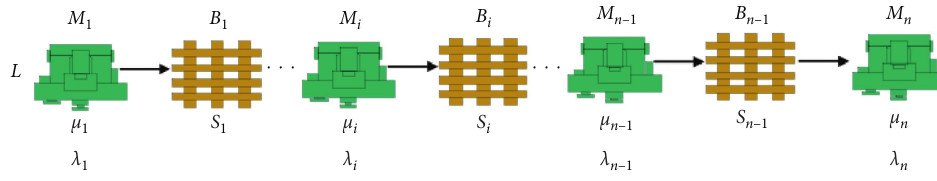
Figure 1: Intelligent series system L .